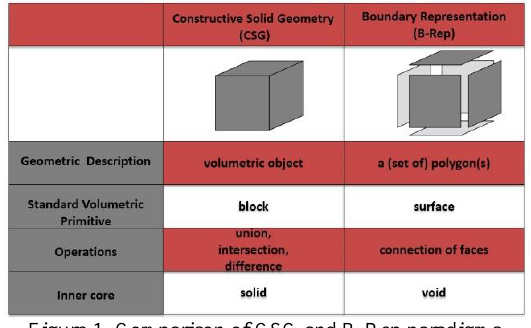
Figure 1. Comparison of CSG and B-Rep